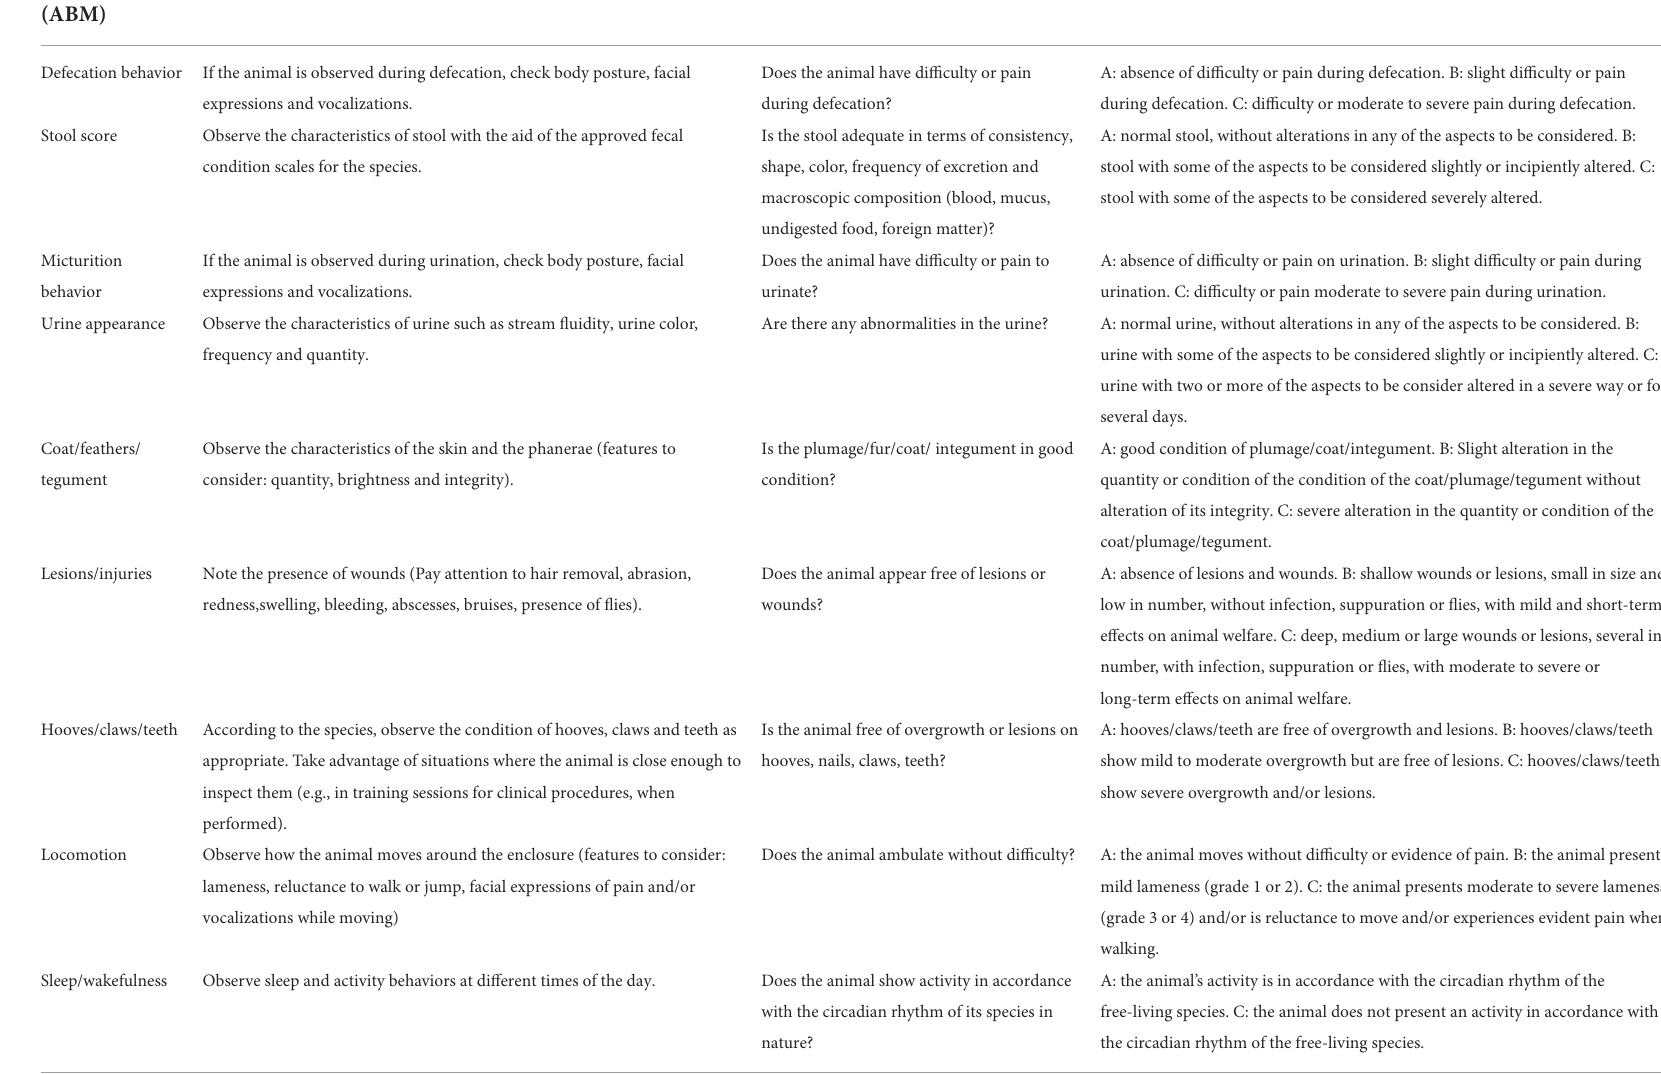
TABLE 7 Summary of the information provided in the user’s manual for assessing health